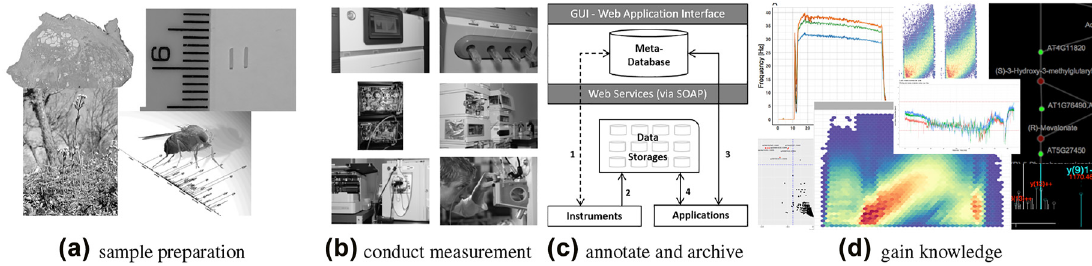
Figure 1: Sketch of a typical omics